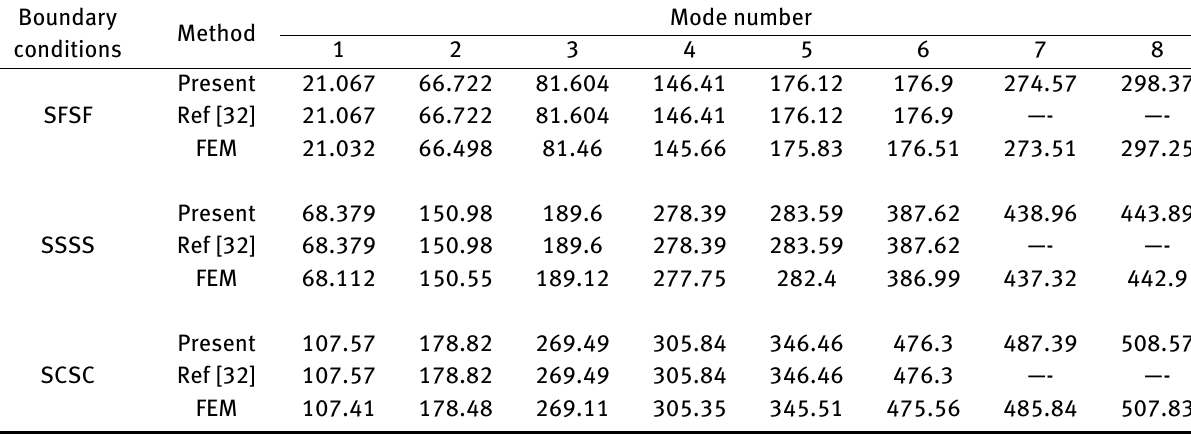
Table 3: Comparison of the frequency parameters Ω for a isotropic thin annular sector plate with different boundary conditions Boundary